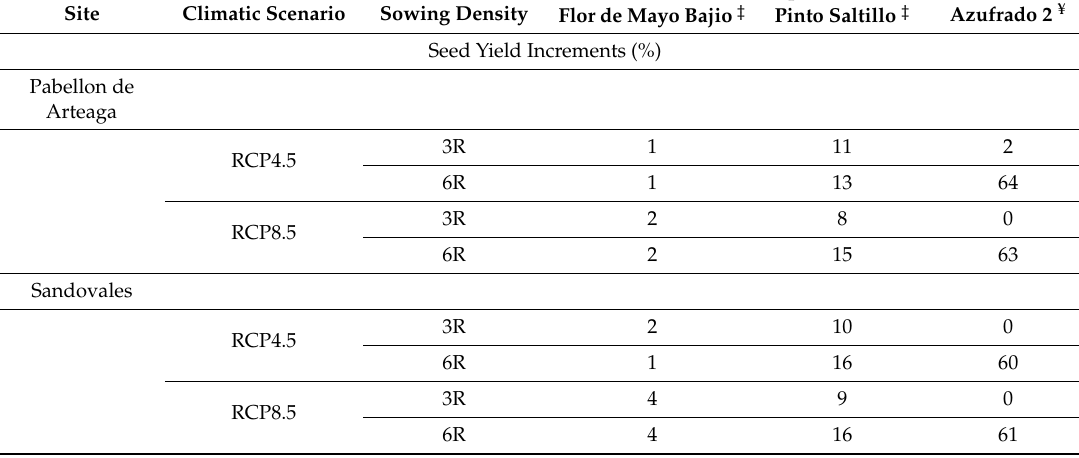
‡ Growth habit III. ¥ Growth habit